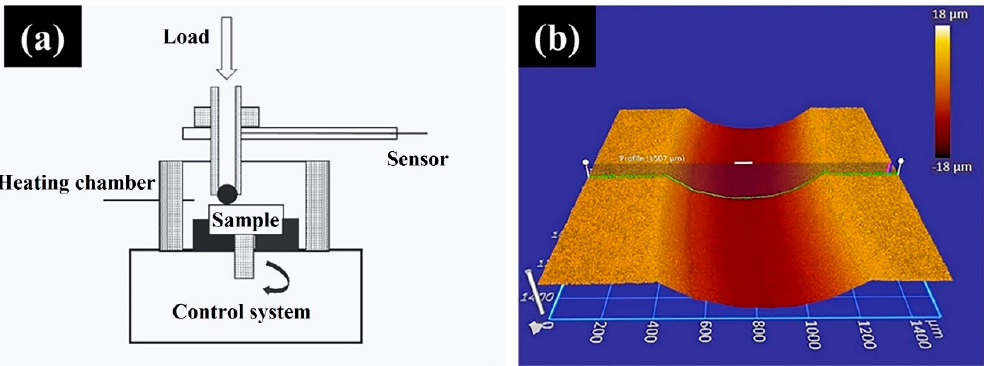
Figure 1. ( a ) Schematic diagram of the ball-on-disc high-temperature testing equipment and ( b ) cross-sectional profile of a wear scar.